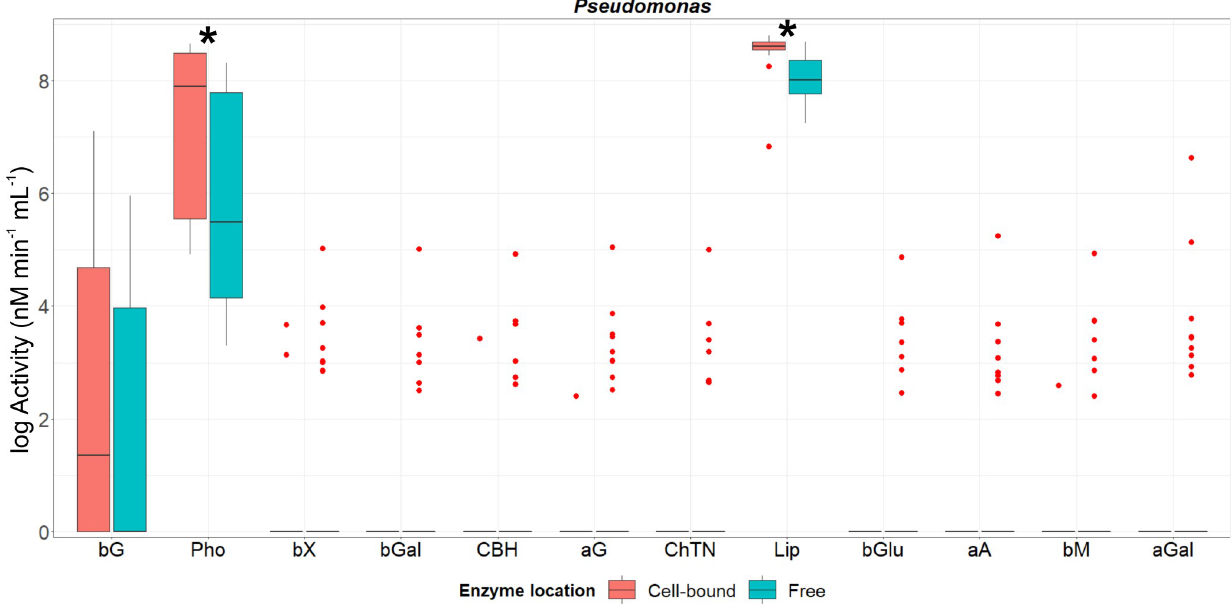
Fig 2. Activity of cell-associated and freely-released enzymes from genus Pseudomonas . Box and whiskers were represented in the style of Tukey. Hinges correspond to the 1 st and 3 th quartiles and medians of the activity of each enzyme recorded for all strains are represented by horizontal lines. Red points correspond to those data beyond 1.5 x Inter Quartile Range. An ‘ � ’ indicates significant differences between the activity of those enzymes detected in both fractions calculated with the non-parametric Mann-Whitney U test at a confidence level of 95%. Abbreviations of enzymes: bG: β -glucosidase; Pho: acid phosphatase; bX : β -xylosidase; bGal : β -galactosidase; CBH: cellobiohydrolase; aG : α -glucosidase; ChTN: chitinase; Lip: lipase; bGlu : β -glucuronidase; aA : α -arabinosidase; bM : β -mannosidase; aGal : α -galactosidase. All the data were log-transformed for graphical clarity by fitting the same scale.